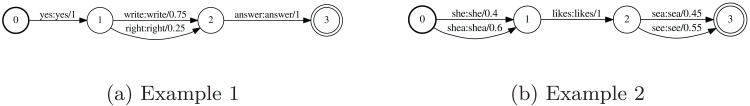
Confusion network examples.